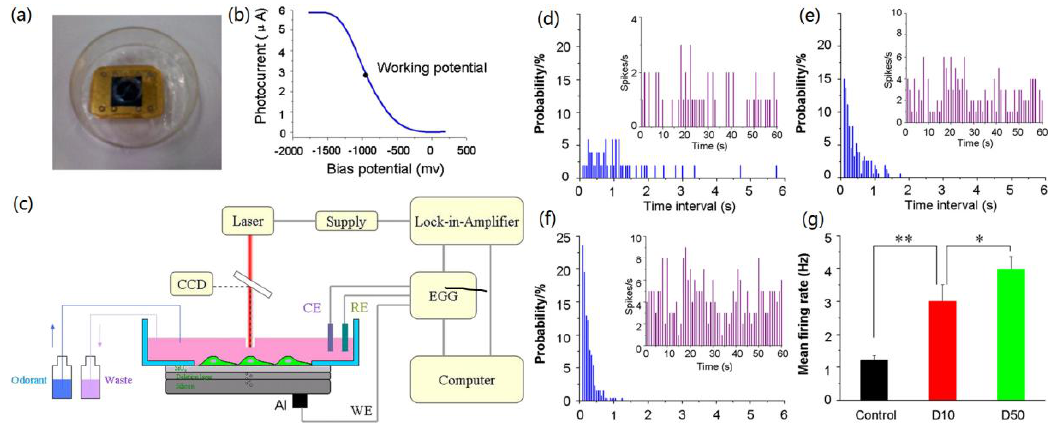
Figure 5. ( a ) LAPS chip with a detection chamber; ( b ) The typical LAPS I-V curve (photocurrent vs. bias potential); ( c ) A schematic diagram of LAPS measurement setup; The temporal response mode recorded by LAPS from bioengineered olfactory receptor neurons under conditions of ( d ) spontaneous firing, i.e., control; ( e ) 10 mM diacetyl stimulation; and ( f ) 50 mM diacetyl stimulation; ( g ) Mean firing rate statistics of control, 10 mM diacetyl (D10) stimulation and 50 mM diacetyl (D50) stimulation [87].